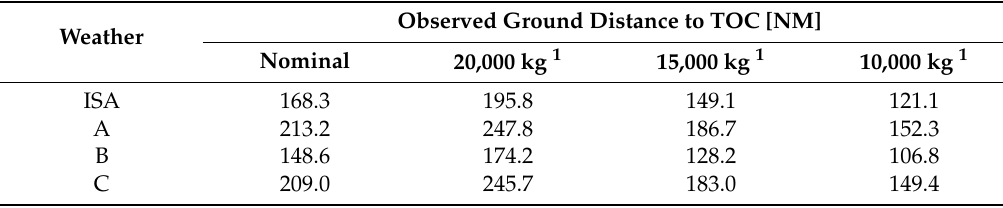
Table 1. Comparison of the observed ground distances to the Top of climb (TOC) for different weather scenarios and the ISA scenario without wind.